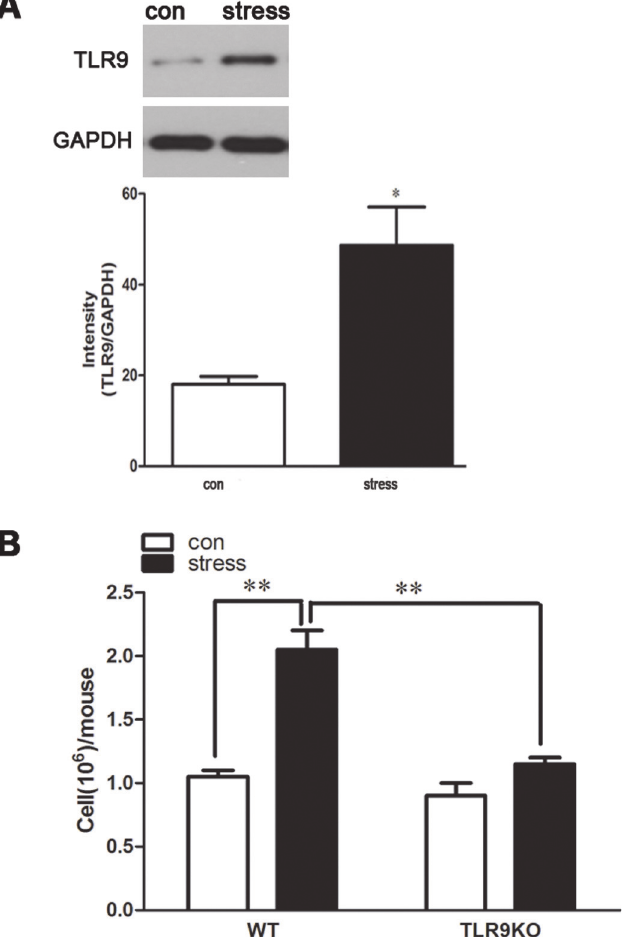
Fig 1. A deficiency of TLR9 blocks chronic stress-induced accumulation of macrophages in peritoneal cavity TLR9 knockout mice or wild type BALB/c mice aged 6 to 8 weeks were subjected to a 12 h physical restraint daily. After 2 d stress, mice were sacrificed by cervical dislocation, and the peritoneal macrophages were harvested and the counts were performed. For TLR9 protein expression evaluating, the macrophages were harvested and cultured for 24 hours. The expression of TLR9 was analyzed by Western blot. Means and SEs were calculated from 7 mice per group. * p < 0 . 05 , ** p < 0 . 01 compared with indicated